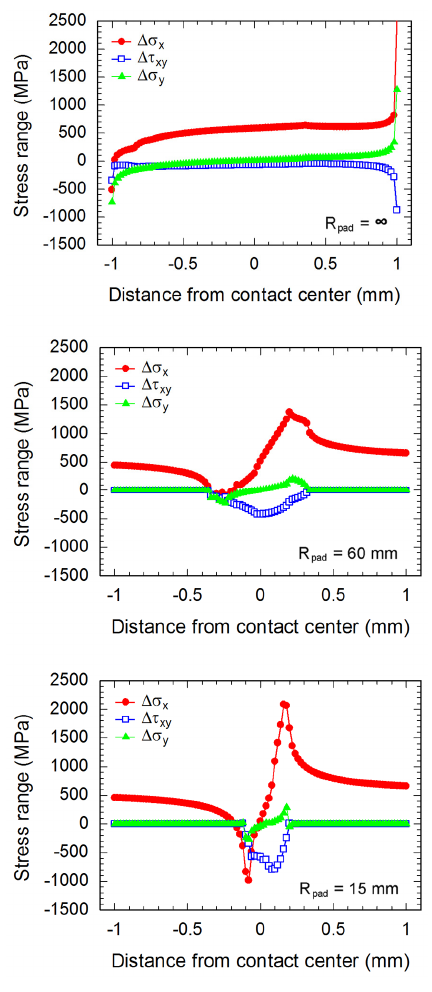
Figure 7. Stress ranges along contacts of fretting fatigue experiments at a stress amplitude of 300 MPa.